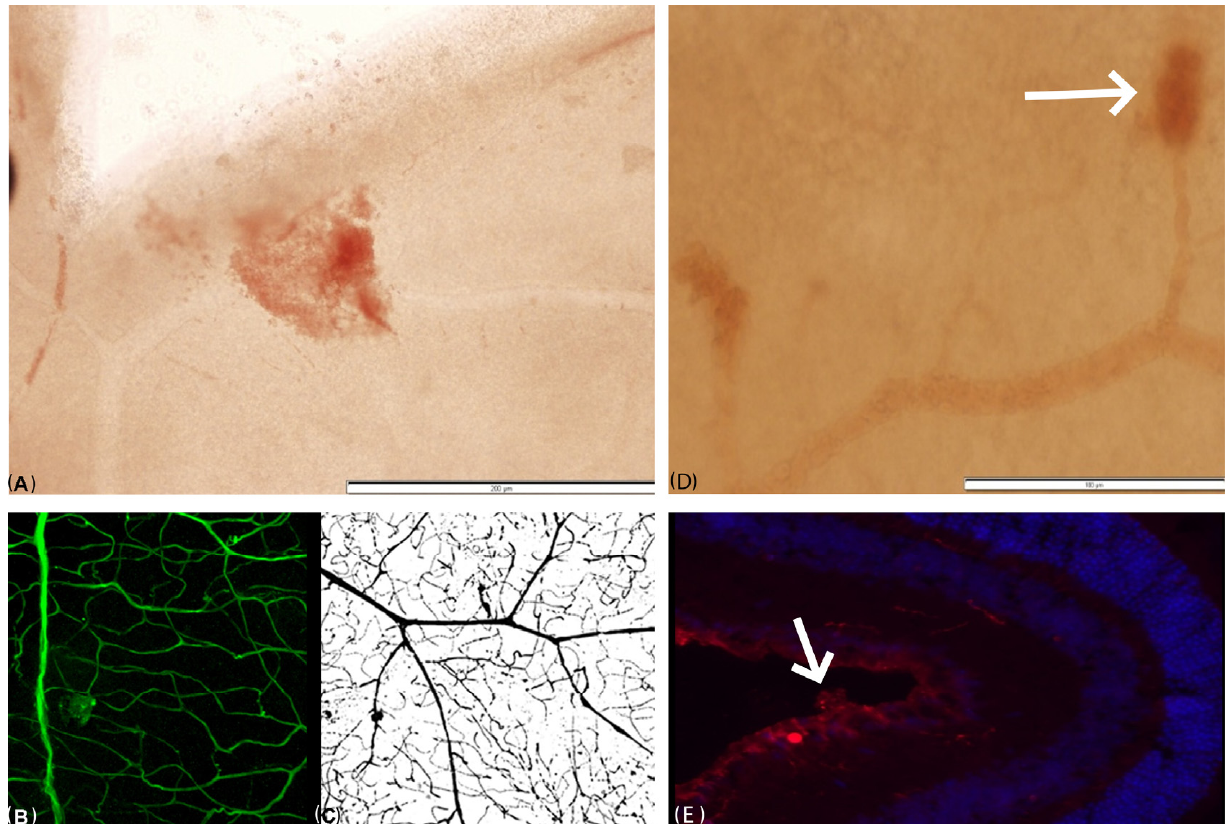
Figure 3. Perfusion studies with flat-mount retinas. ( A ) Flat-mount retina without perfusion. The intravitreal fan-shaped vascular bulging suggests pathological proliferation of retinal vessels. ( B ) Flat-mount retina perfused with fluorescence gel, demonstrating tortuosity of the vessels and an area suspected to be tufts of neovascularization. ( C ) Flat-mount retina perfused with India ink, showing sacculation of the retinal vessels. The findings suggest relaxation of the retinal wall and microaneurysms. Another DMT2 db/db mouse showed vascular leakage ( D ), with neovascularization noted upon sectioning ( E